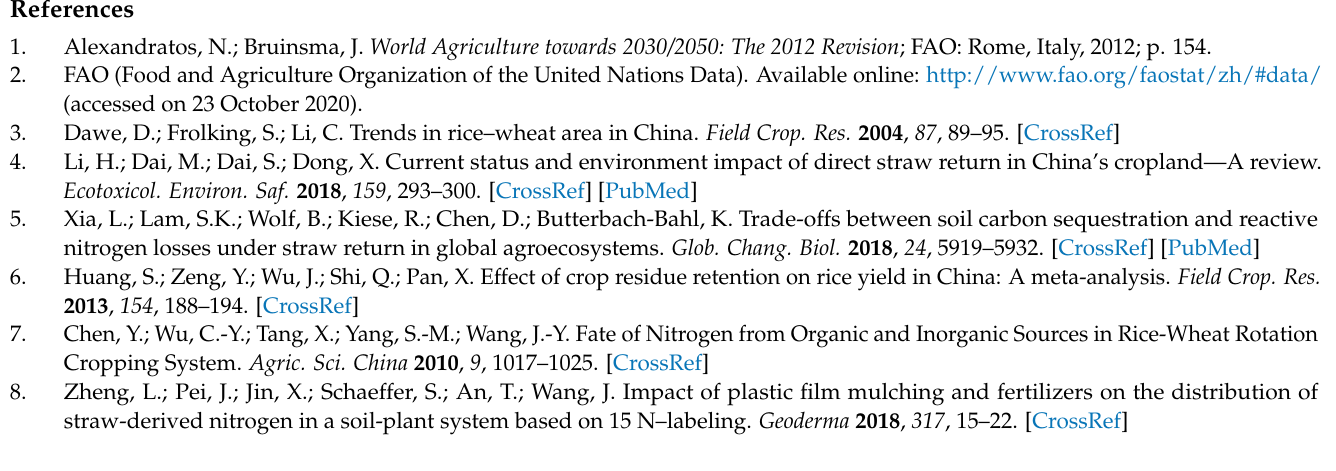
the soil–rice system. Table S2: Biomass in different parts of rice under different treatments (g pot − 1 ). Table S3: Total N absorption in different parts of rice under different treatments (mg pot − 1